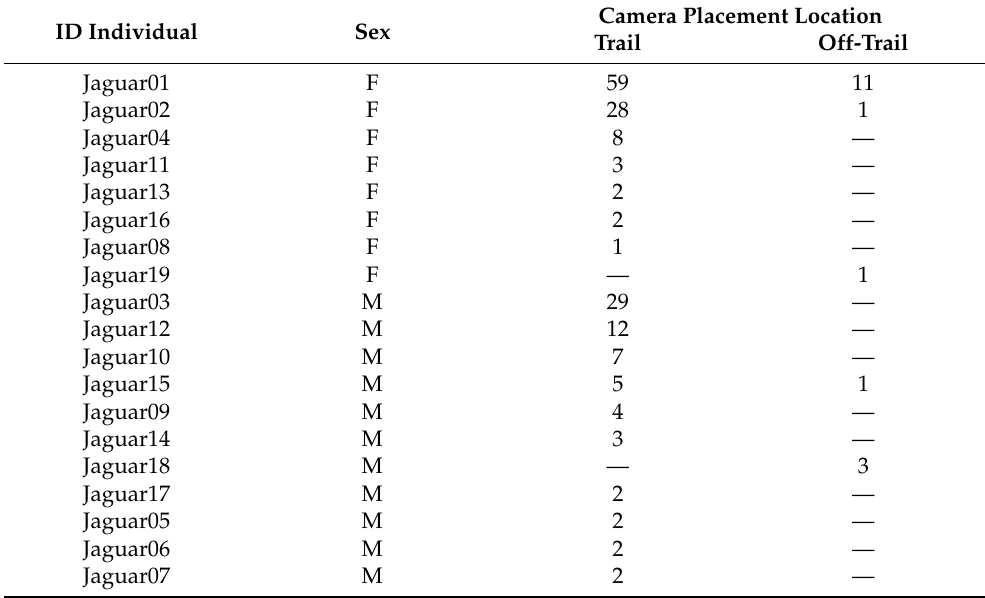
Table 1. Individual jaguar captures registered at different sites (trail/off-trail) in Sector Santa Rosa, Guanacaste Conservation Area, Northwestern Costa